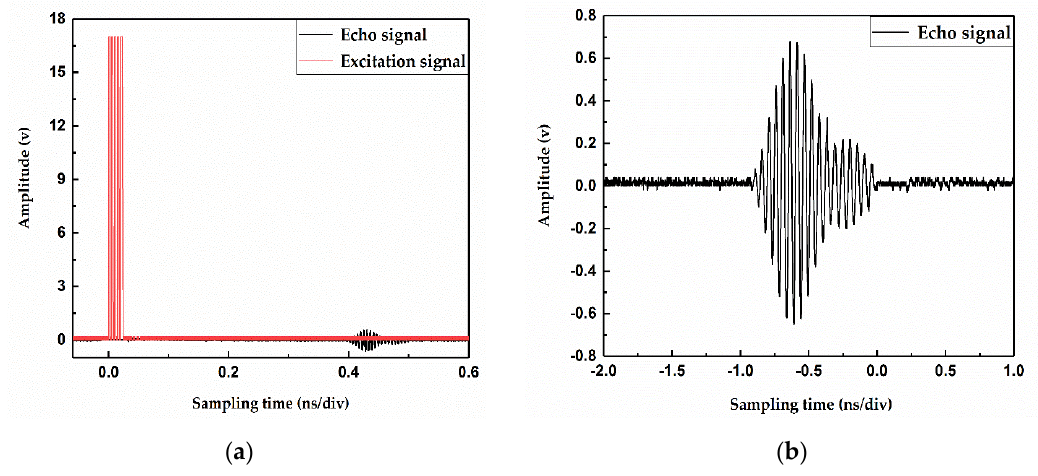
Figure 5. ( a ) Signal processed before the receiving circuit; ( b ) signal obtained by the receiving circuit.